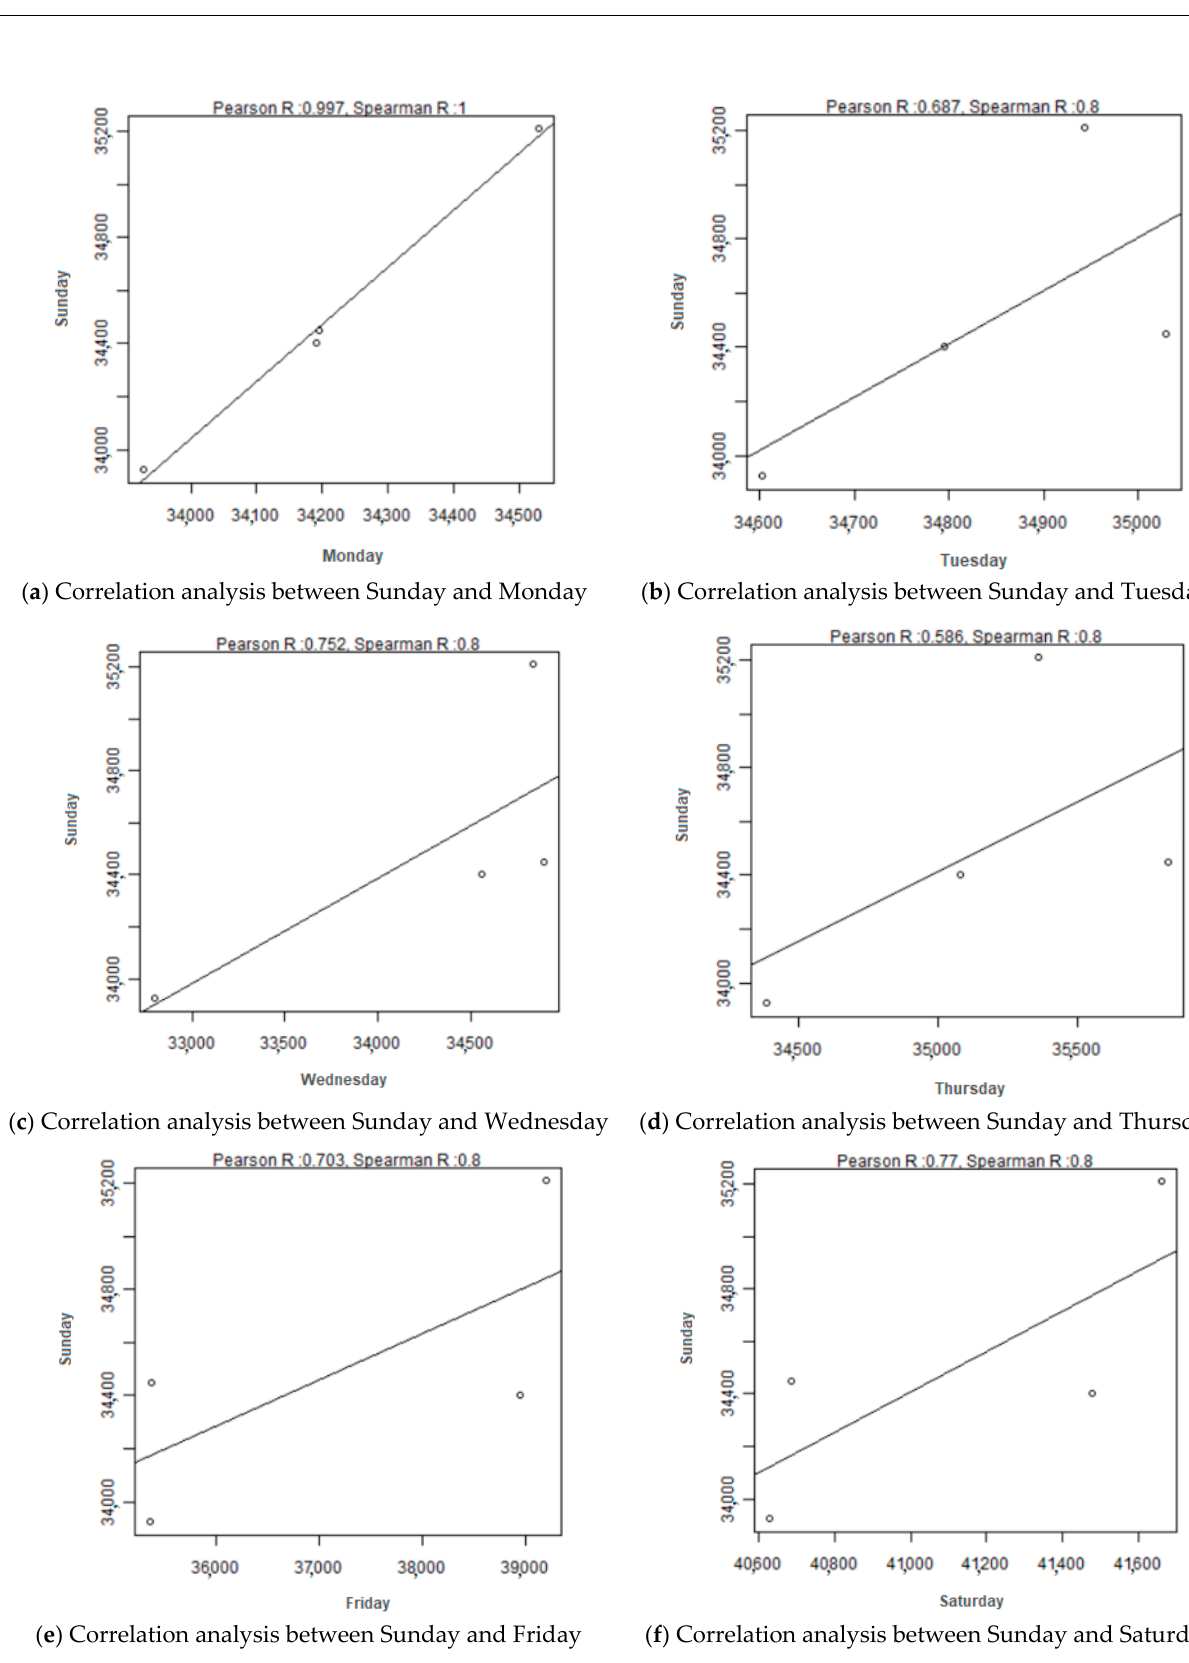
Figure 15. Correlation analysis graph for each day of the week on Sunday: all vertical and horizontal axis is traffic volume and ( a ) is correlation analysis between Sunday and Monday; ( b ) between Sunday and Tuesday; ( c ) between Sunday and Wednesday; ( d ) between Sunday and Thursday; ( e ) between Sunday and Friday; and ( f ) between Sunday and Friday.